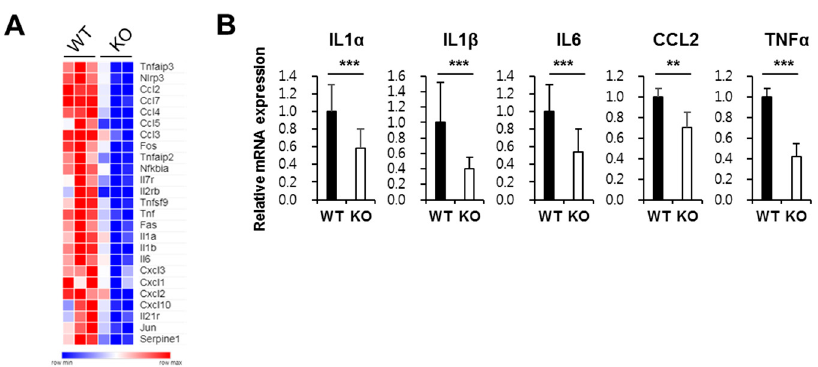
Figure 4. Differences in mRNA expression profiles of macrophages from WT and Ninj1 KO mice ( A ) Heat map of inflammation-related gene expression in peritoneal macrophages from WT and Ninj1 KO mice based on microarray analysis; n = 3 per group. ( B ) qRT-PCR was performed to confirm the genes of interest identified by microarray analysis. Data are presented as mean ± SEM. ** p < 0.01, *** p < 0.005, Student’s t -test.